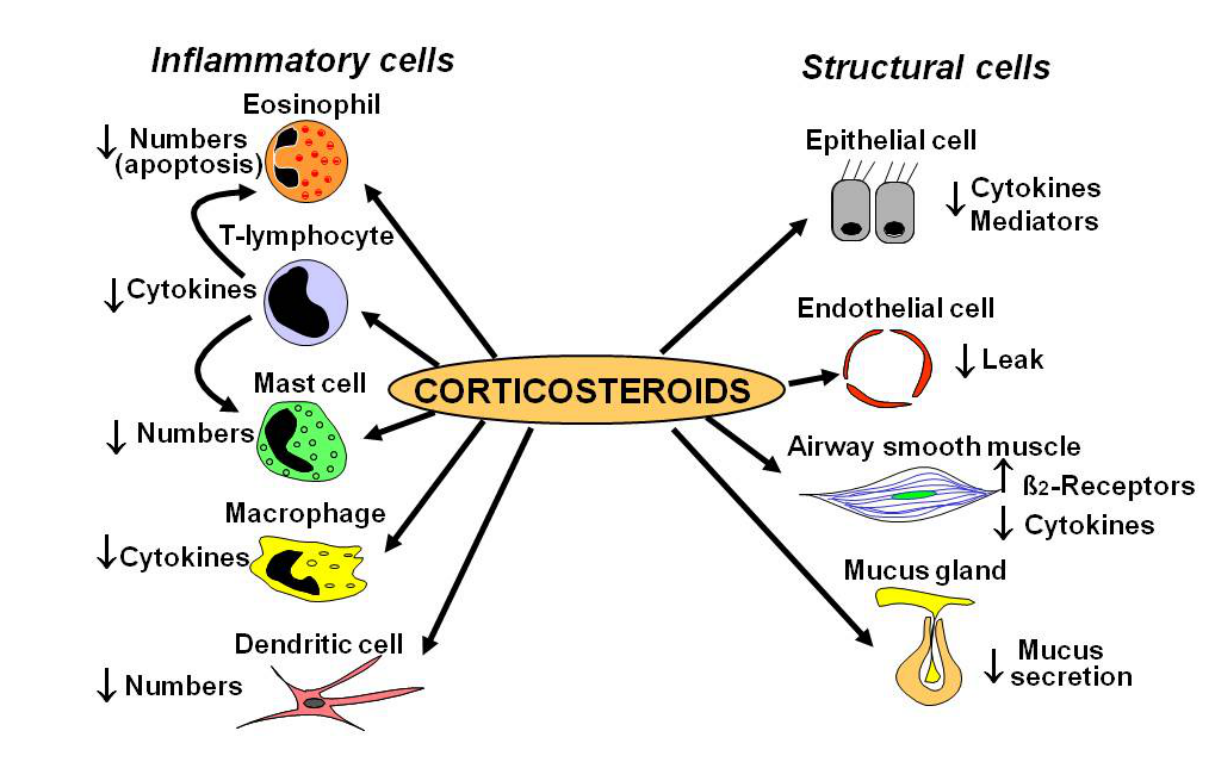
Figure 1. Cellular effect of